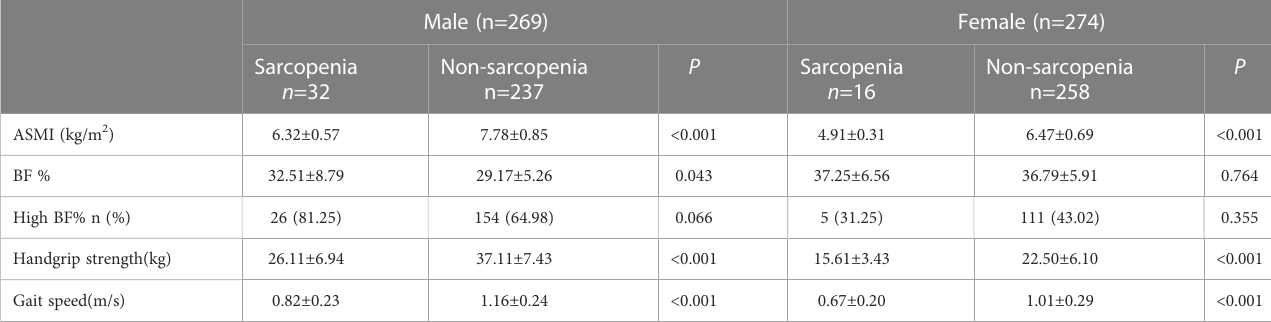
TABLE 3 Body composition and muscle function according to sex and sarcopenia status.